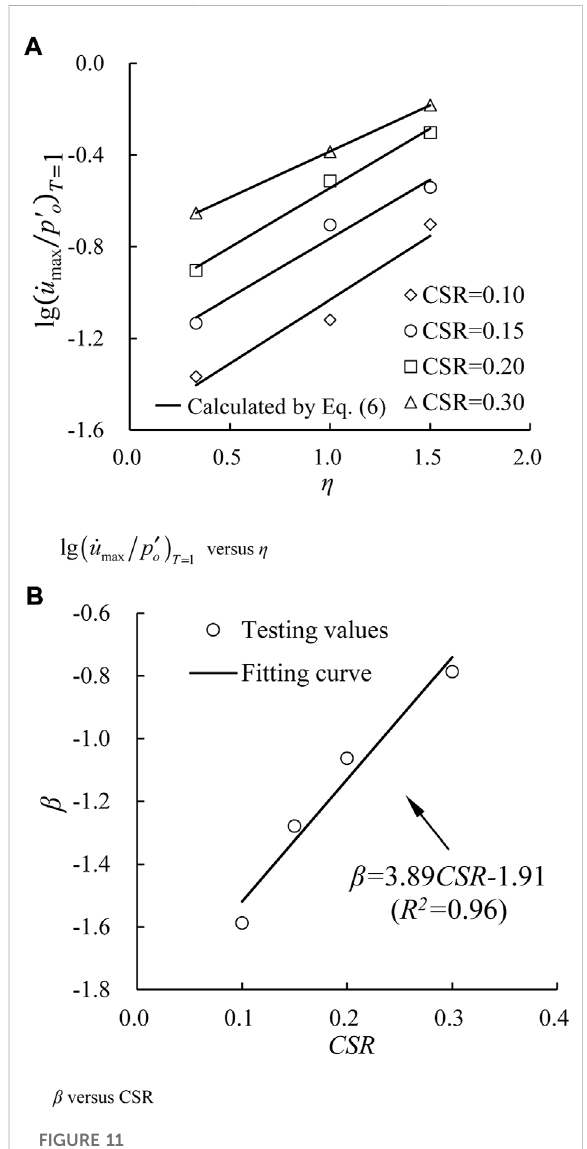
FIGURE 11 Determinationof fi ttingparameters. (A) lg ( _ u max / p ′ o ) T (cid:1) 1 versus η and (B) β versus CSR.